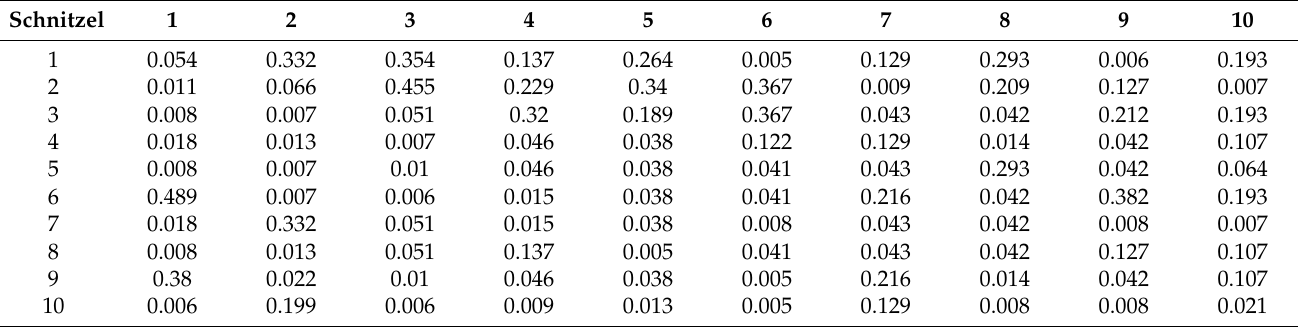
Table A11. Normalization matrix of schnitzel.